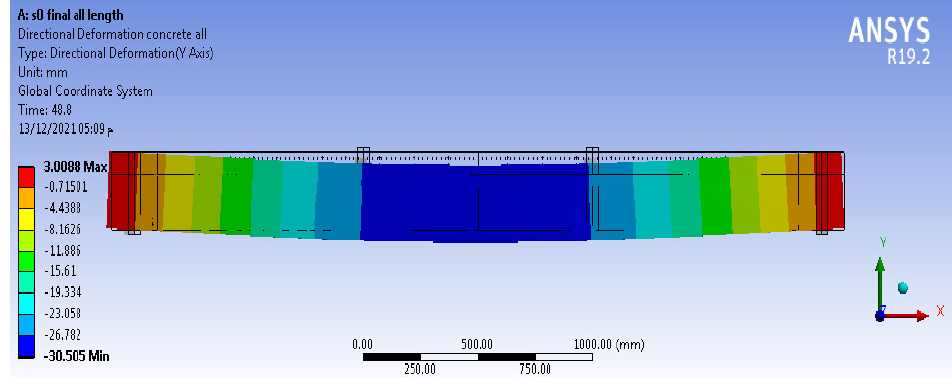
Figure 9. Deflection of sample S 0 at failure.